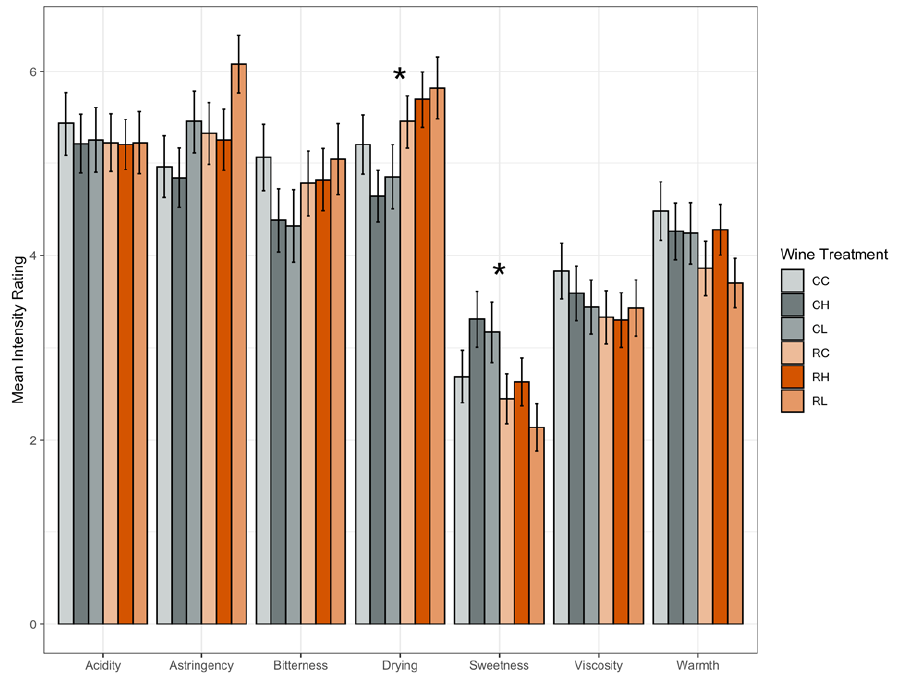
Figure 6. Mean perceived intensity rating (mean ± standard error) for taste and mouthfeel attributes in descriptive analysis test of wine treatments. * indicates significant difference (two-way ANOVA, α =